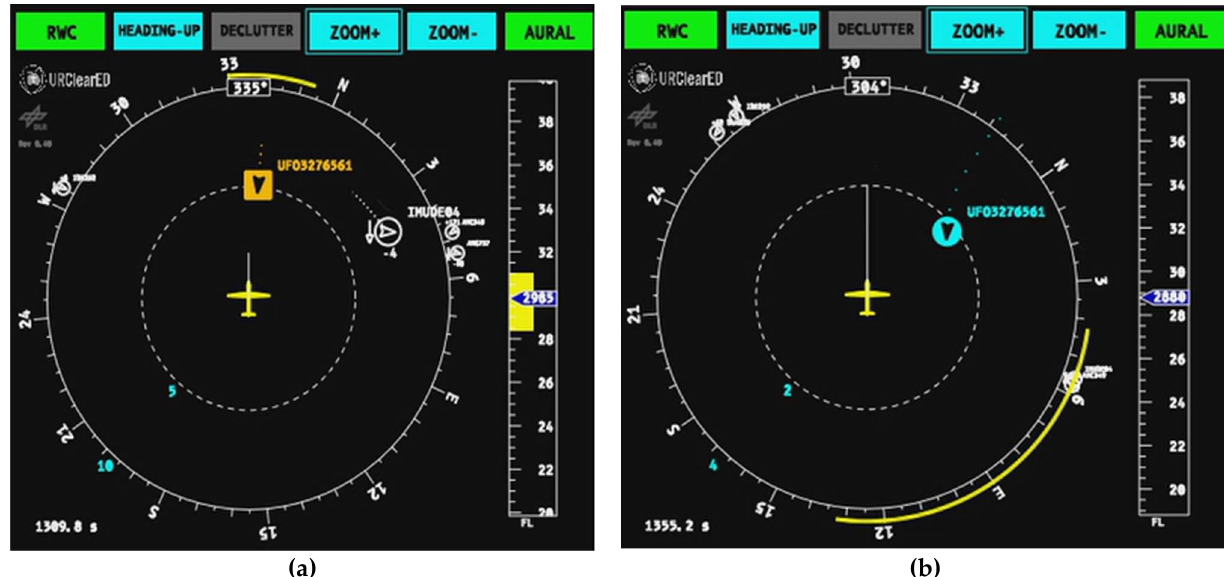
Figure 17. The CDTI before ( a ) and after ( b ) the Remain Well Clear